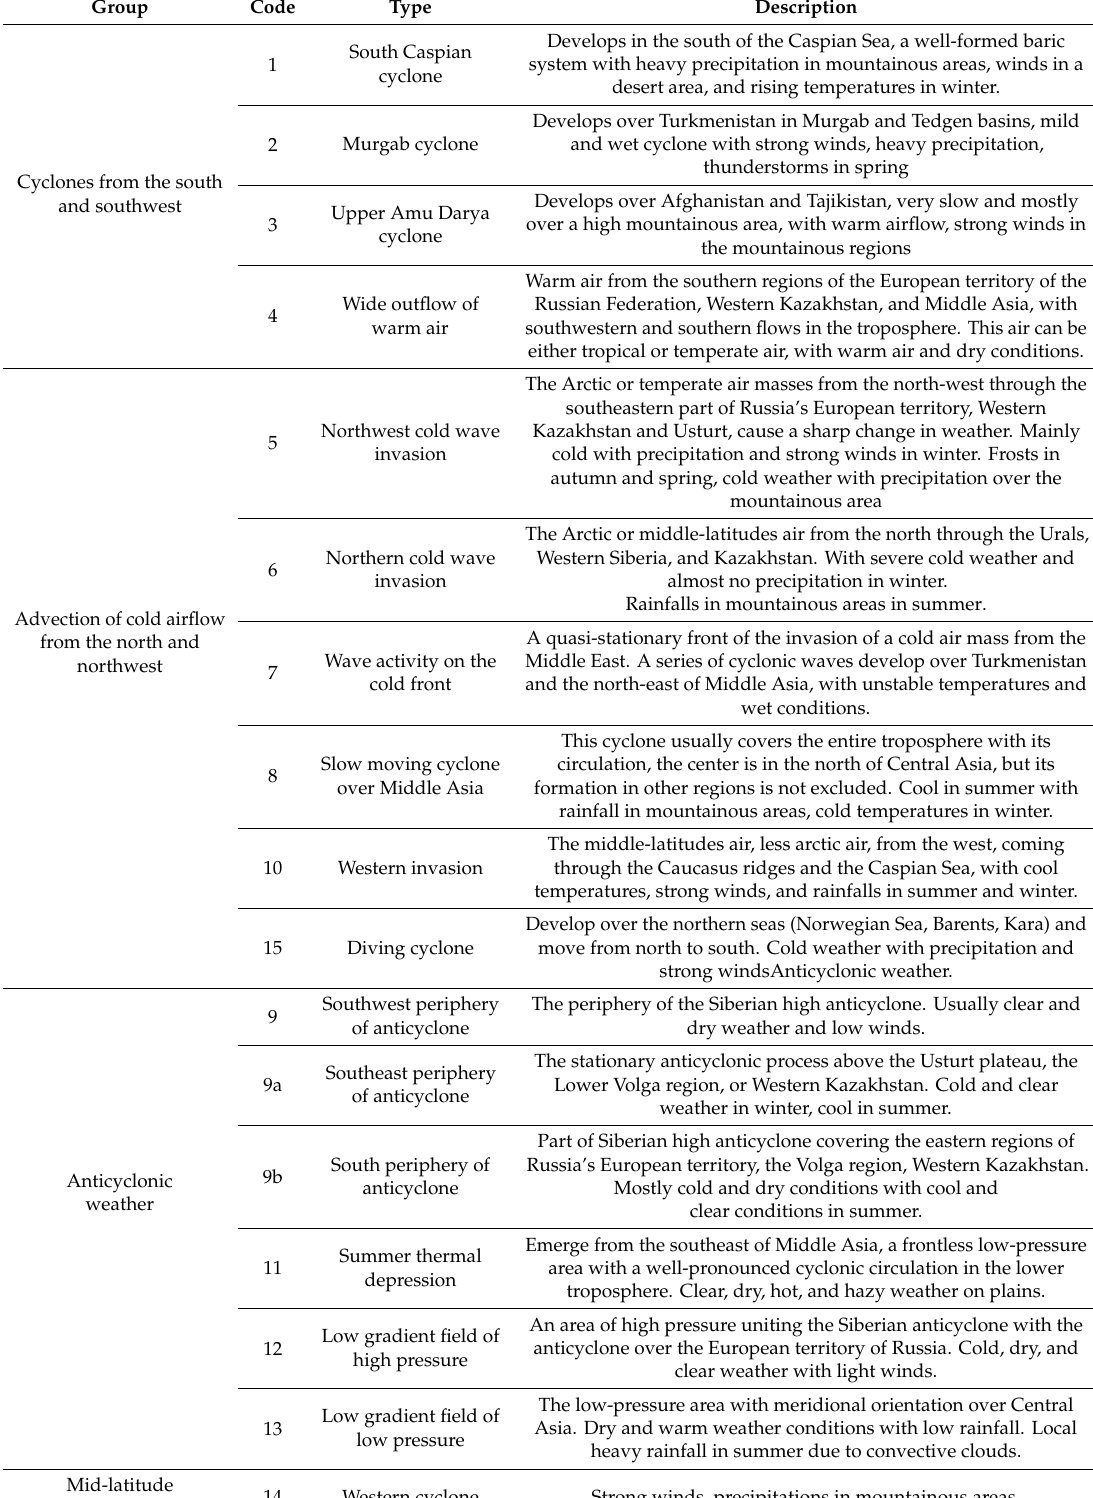
TableA1. SynopticweathertypeclassificationbytheUzHydromet. Source: Bugaev,Inogamova et al. [15–17]. Group Code Type